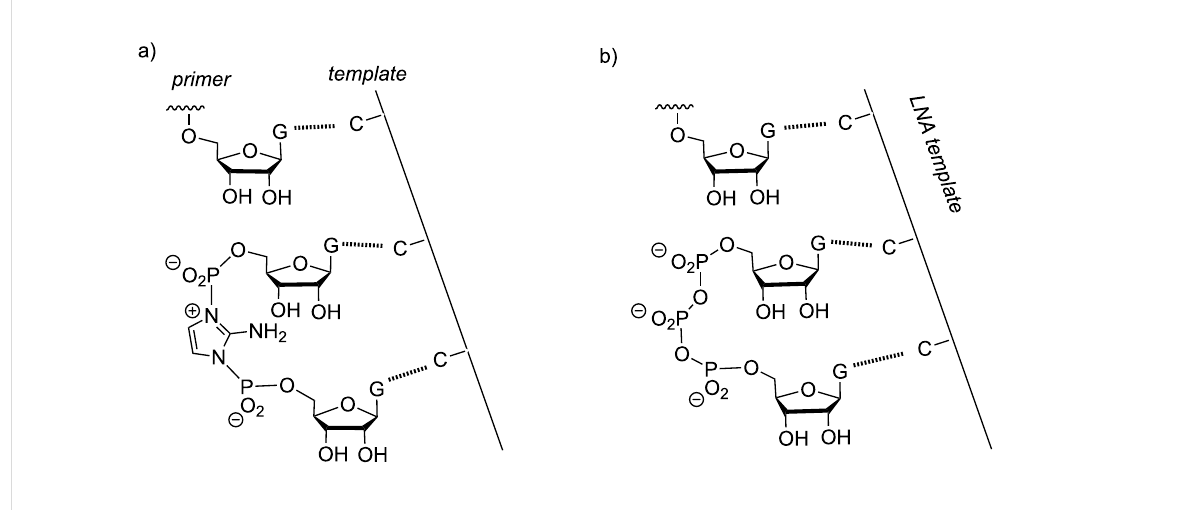
Figure 14: Imidazolium bisphosphate as intermediate in the primer extension reaction, as described by Szostak and colleagues. a) Intermediate of an extension with aminoimidazolides as monomers [52]; b) one of the structural arrangements found in a recent crystallography study that used oligophosphates as model compounds